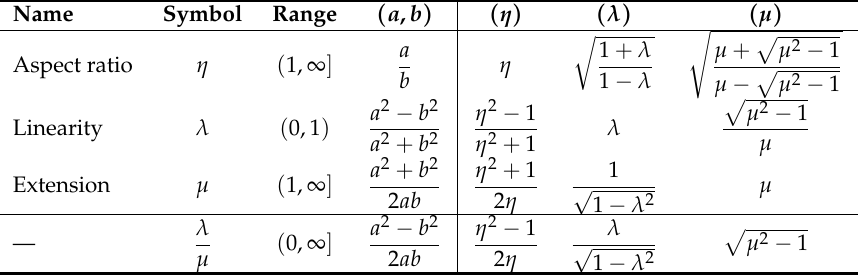
Table 2. A comparison of four different quantities describing ellipse shape. Each quantity is expressed in terms of the first three, as well as in terms of the major and minor semi-axis lengths a and b